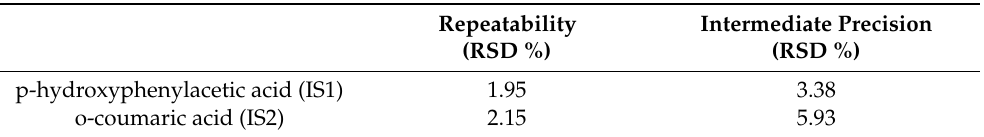
Table 1. Repeatability and intermediate precision of the internal standards (IS) used for the quantifi- cation pf phenols.